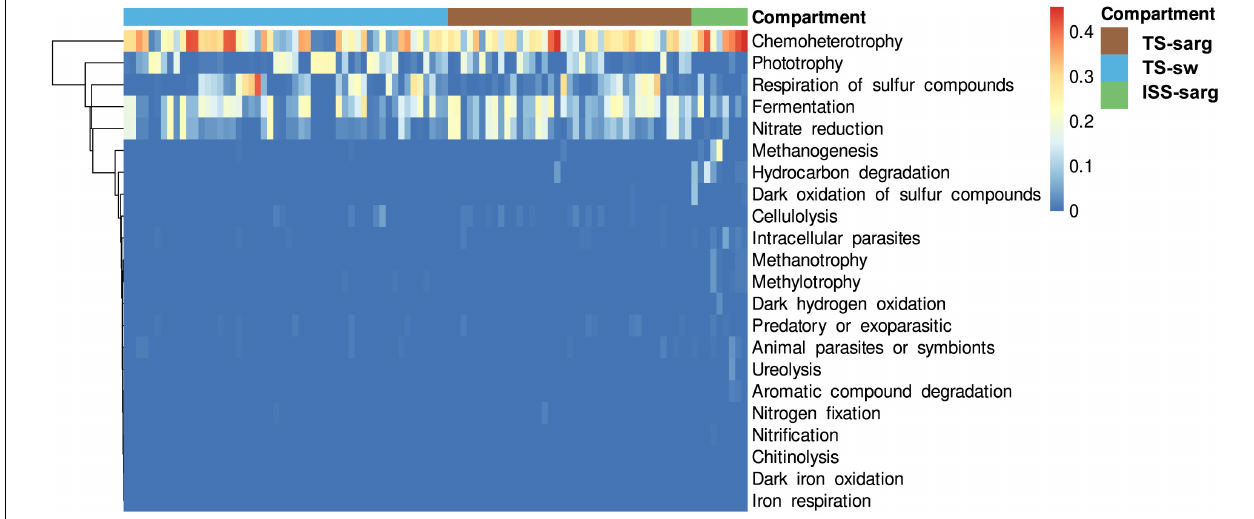
FIGURE 6 | Heatmap of predicted functions based on the FAPROTAX database. The 22 categories presented here correspond to 2,831 prokaryotic OTUs. Functions were clustered with the weighted pair group method centroid (WPGMC) algorithm based on Euclidean distances. The color scale represents the proportion of each predicted function within a